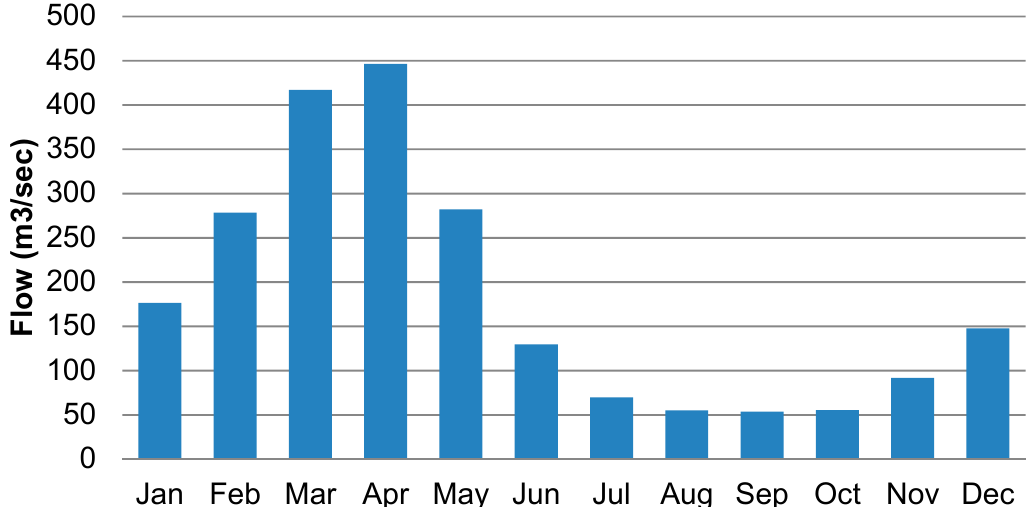
Figure 2. Seasonal distribution of flow recorded before Dukan Dam.